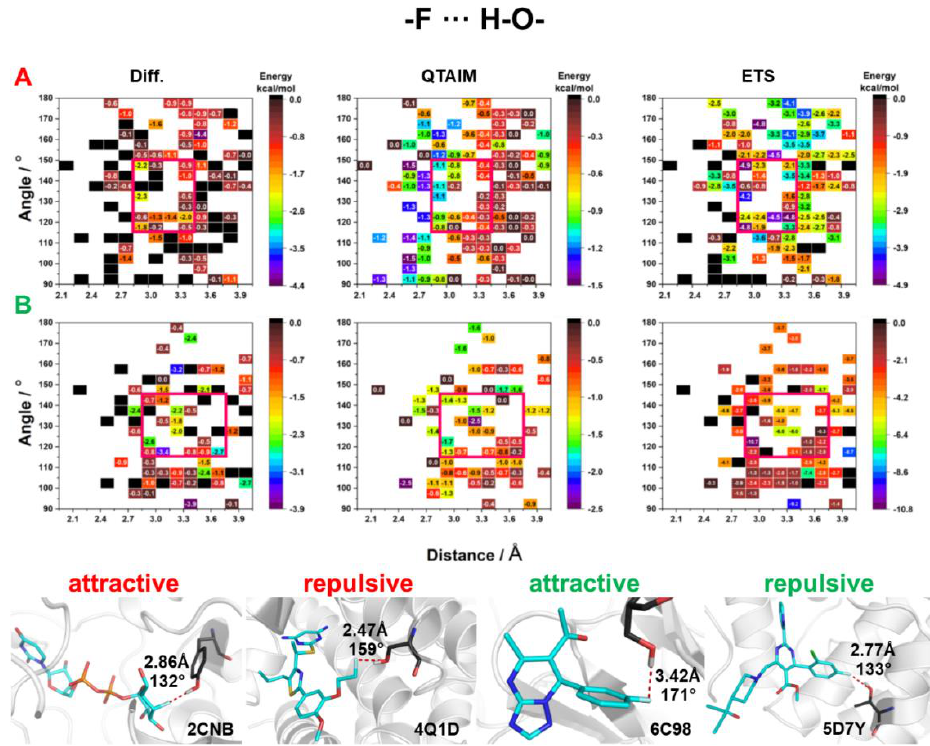
Figure 6. HB energy maps generated based on Diff, QTAIM, and ETS calculations of interaction energy between OH donor and fluorine attached to ( A ) an aliphatic fragment and ( B ) an aromatic ring for specific geometric parameters. The areas for which the highest stabilizing energy was observed in all three methods are marked with a red square.